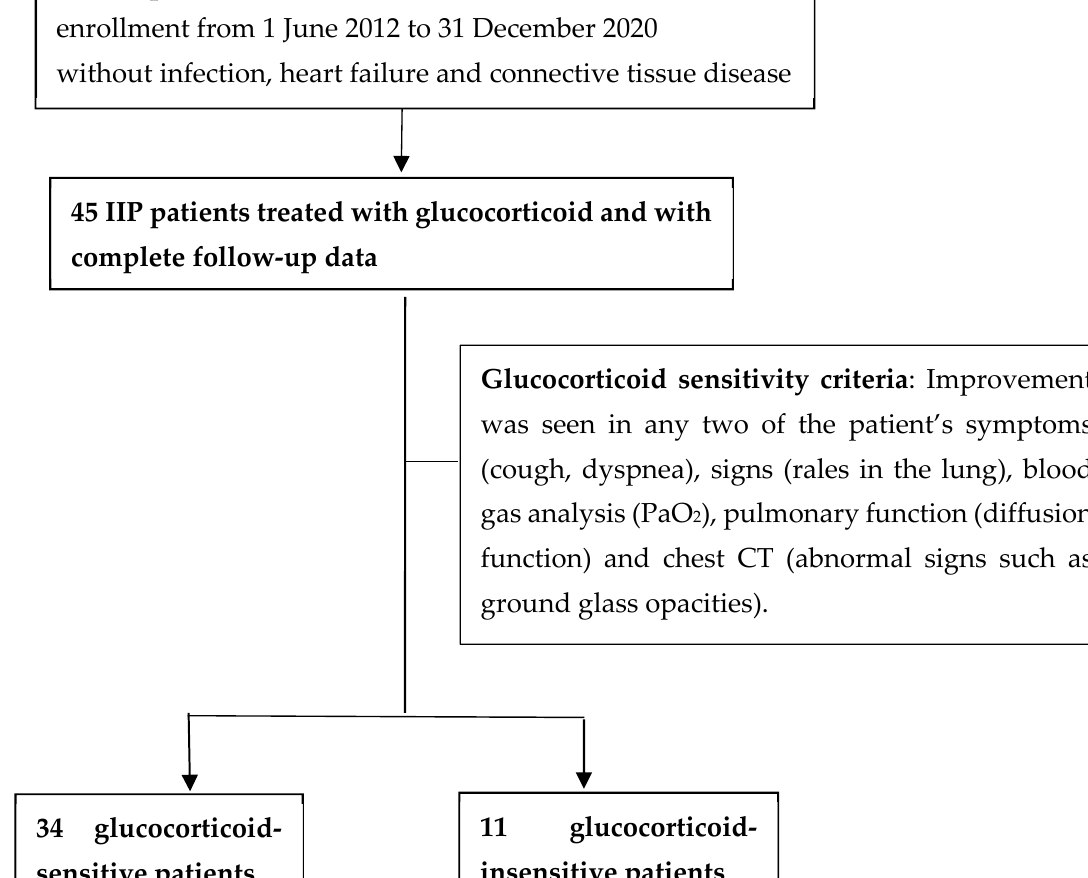
Figure 1. Glucocorticoid-sensitivity grouping